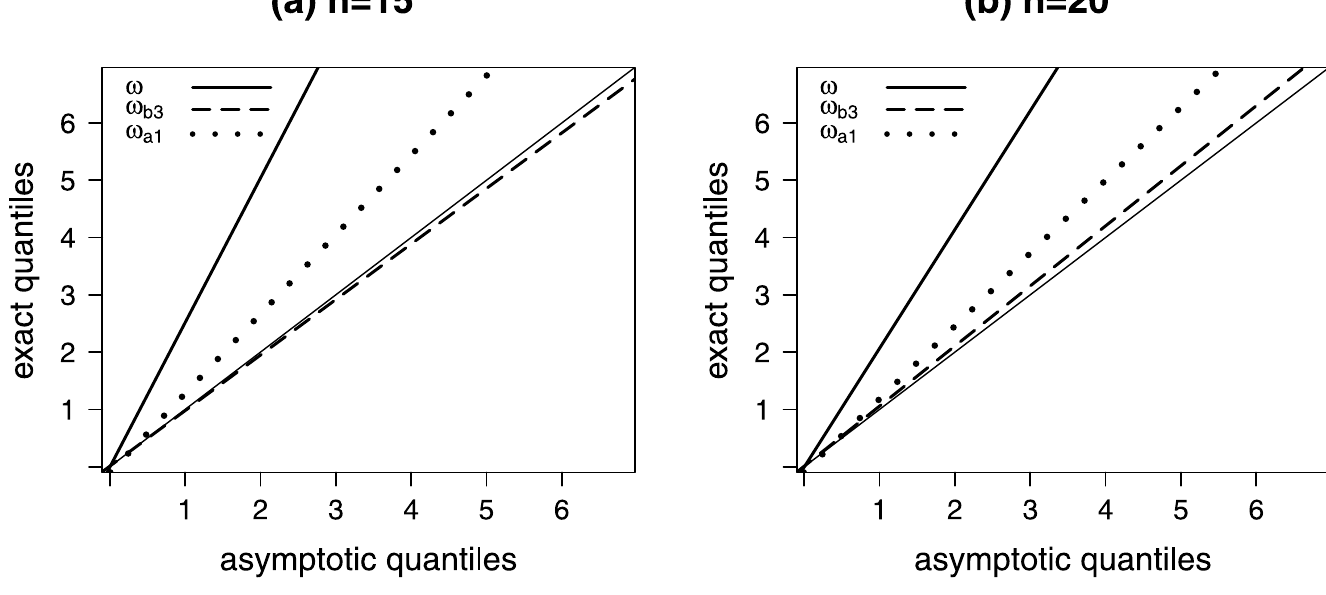
Fig 1. Quantile-quantile plots, H